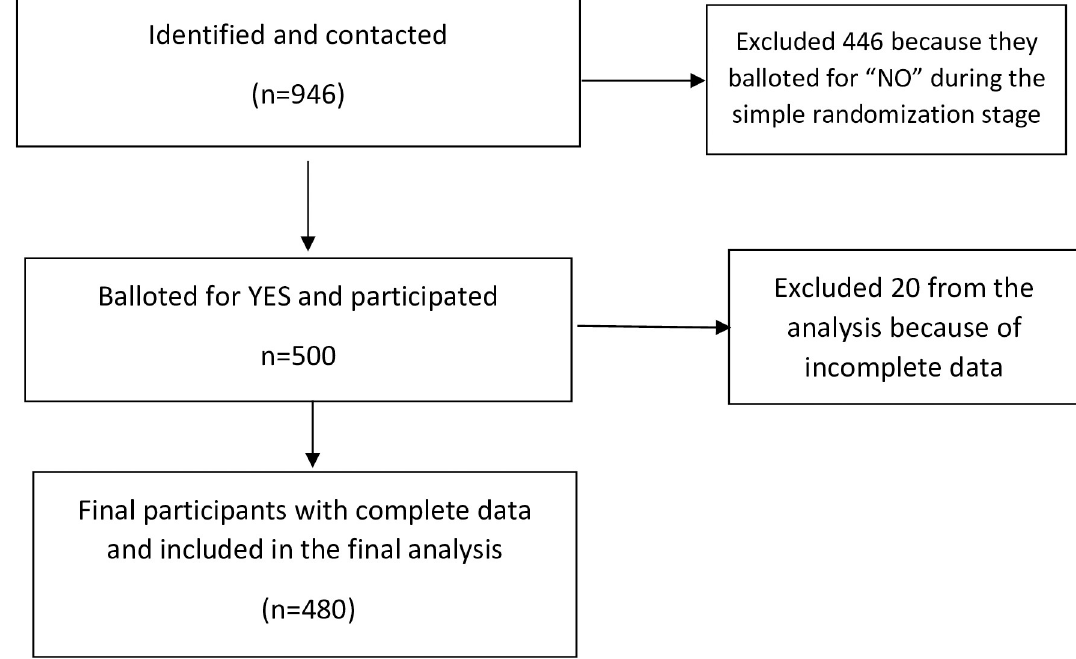
Fig 1. Flow chart for the recruitment of